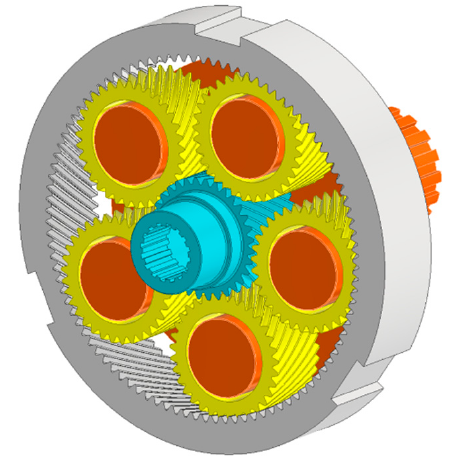
Figure 1. KISSsoft virtual 3D model of typical planetary gearbox.